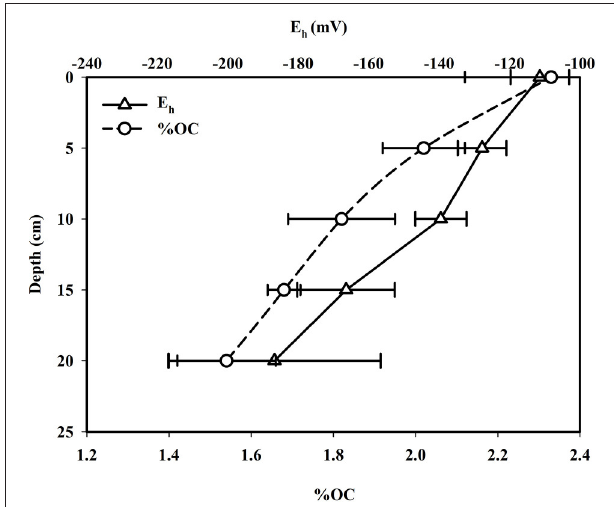
FIGURE 2 | Vertical distributions of E h and percent OC in mangrove sediment.